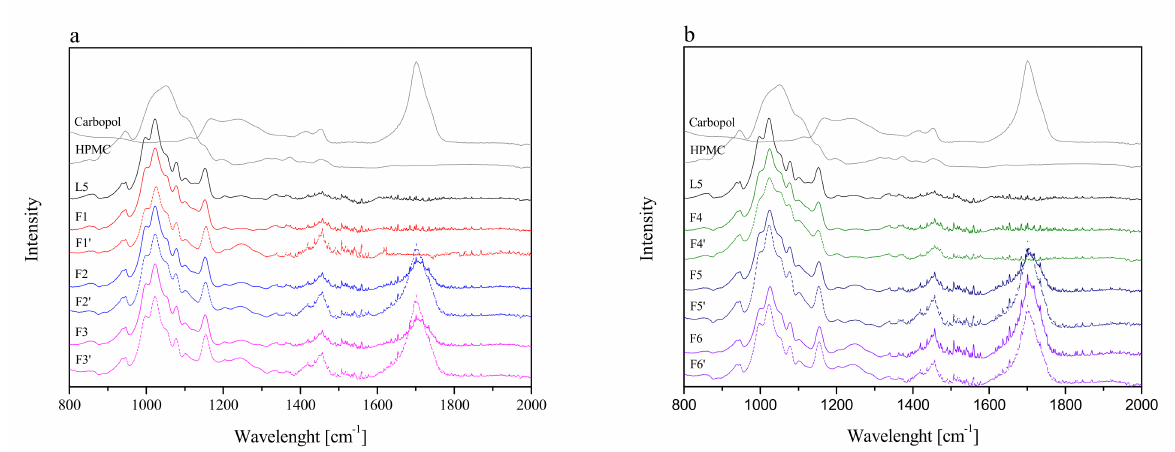
Figure 3. FTIR-ATR spectra of lyophilized extract L5 and formulations F1–F3 ( a ) and F4–F6 ( b ), where F1–F6 corresponds to formulations F1–F6 and F1 (cid:48) –F6 (cid:48) corresponds to the theoretical sum of the spectra of the lyophilized extract L5 and the excipient base used to prepare the formulation F1–F6.